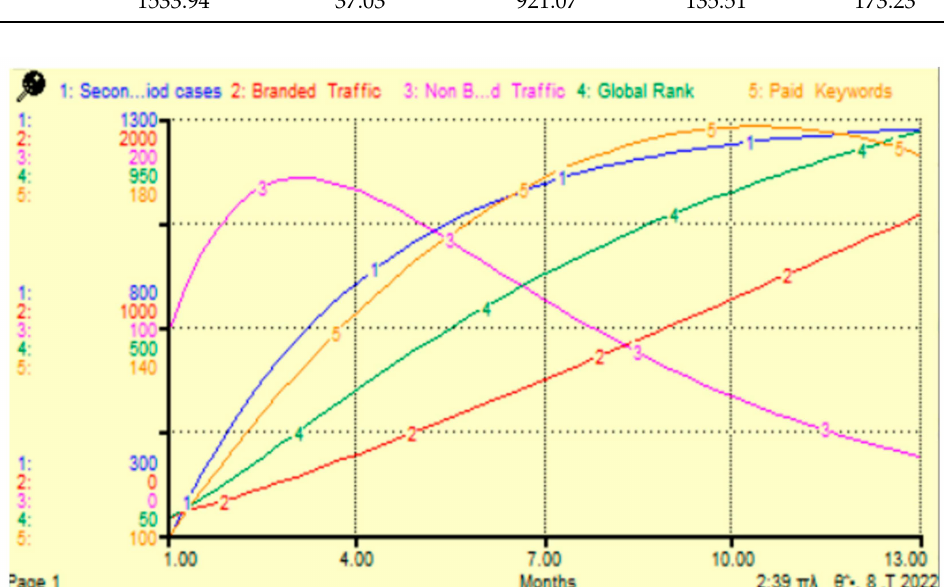
Figure 9. “Crisis within a crisis effect” dynamic simulation (FCM scenario